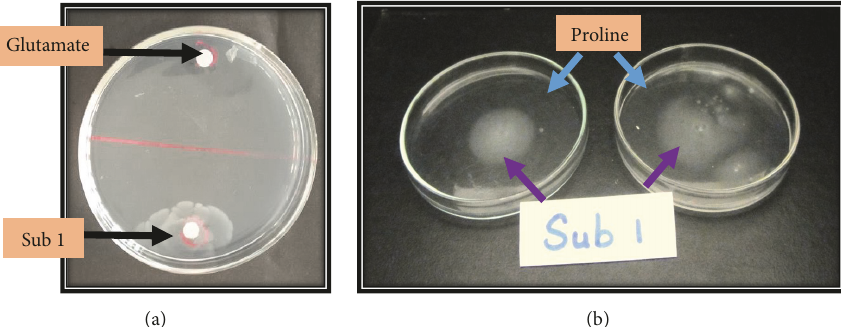
Figure3:ChemotacticswarmplatefortheassessmentofmovementofSub1towardsglutamatethroughswarmbehavior(a)andtheswarming pattern of Sub1 to proline (b).